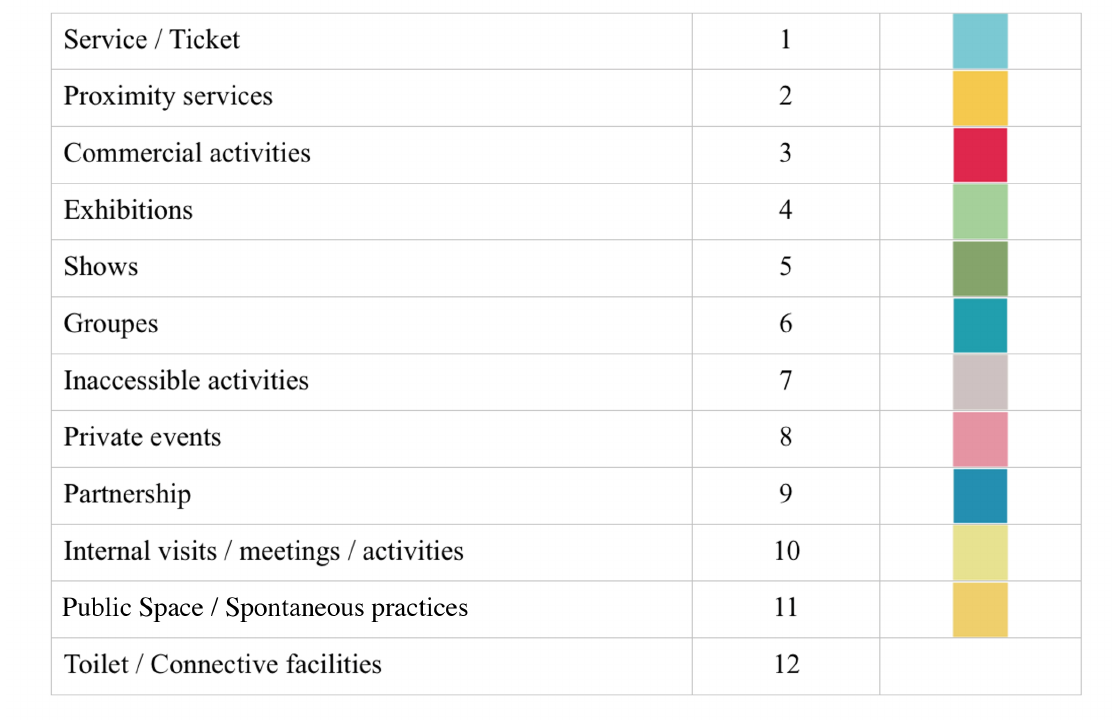
Figure 7. The table of uses for Centquatre together with the numerical and color code used for the analysis. The center’s spaces are divided into 67 cells. If each is in one of the 12 possible states, the possible configurations of purpose of the center are 12 67 , a gigantic number of the order 10 72 . Of course, not all areas can have all of the functions, but even if the number of targeted configurations is reduced, it is large enough to support statistical